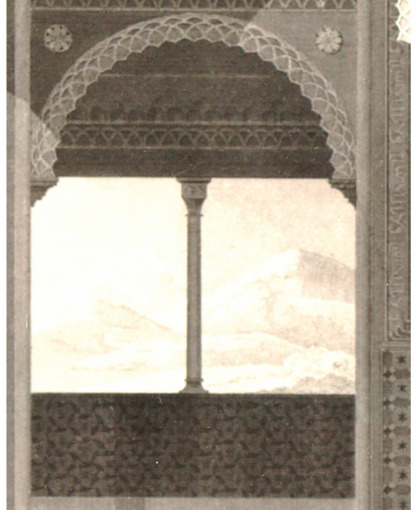
Figure 15. Detail of the alicatados on the portico and north wall of the Cuarto Dorado (Plate XXVIII). Drawing by James Cavanah Murphy (1813). © Archivo del Patronato de la Alhambra y Generalife, Fondo Romanones, A-5-3-13.